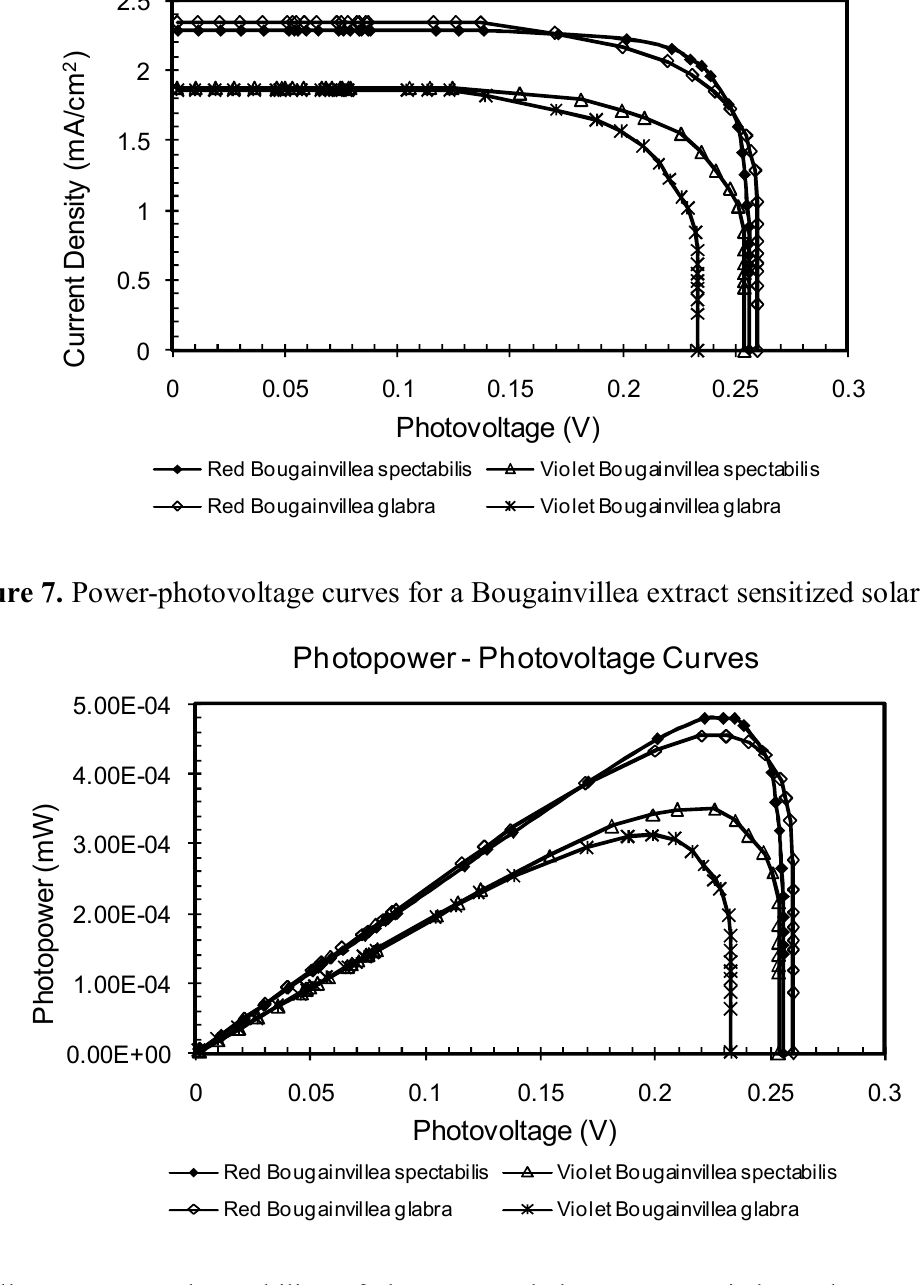
Figure 6. Photocurrent-photovoltage curves for a Bougainvillea extract sensitized solar cell.